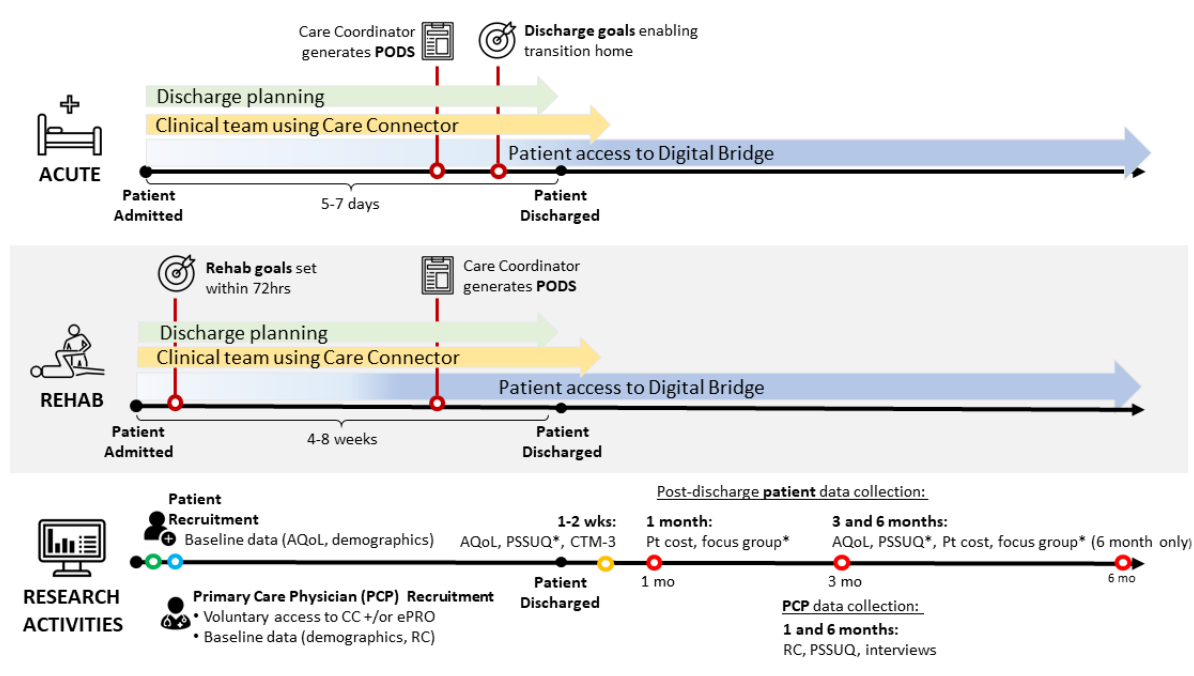
Figure 1. Proposed Digital Bridge workflow and trial data collection